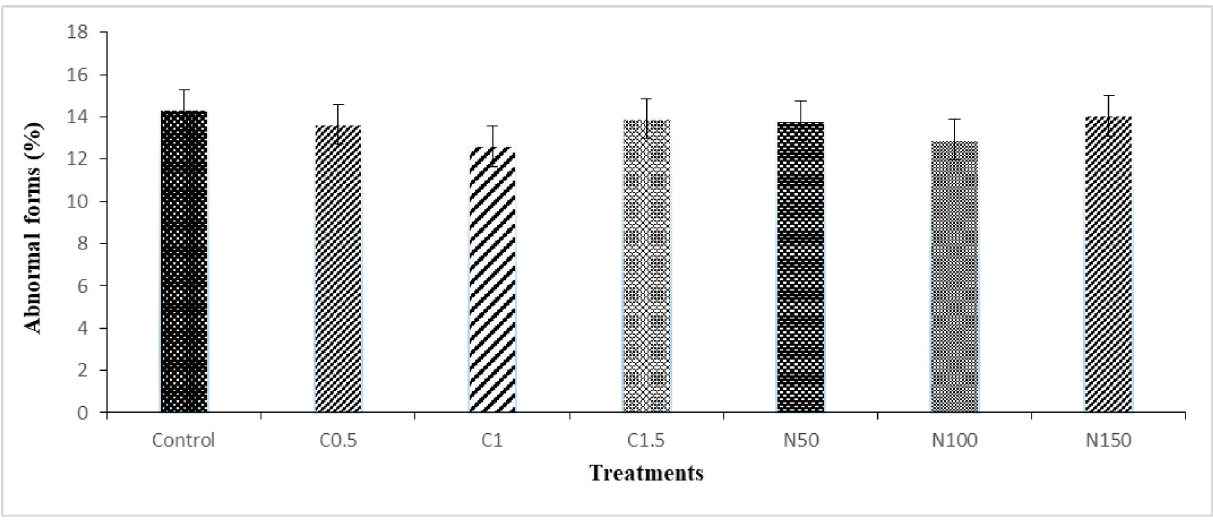
Fig 5. Effect of crocin and naringenin supplementation in cryopreservation medium on post-thawed abnormal forms (%, Hancock solution) of rooster sperm. Beltsville extender without antioxidant (control), C0.5 (Beltsville extender with 0.5 mM crocin), C1 (Beltsville extender with 1 mM crocin), C1.5 (Beltsville extender with 1.5 mM crocin), N50 (Beltsville extender with 50 μ M naringenin), N100 (Beltsville extender with 100 μ M naringenin), N150 (Beltsville extender with 150 μ M naringenin).